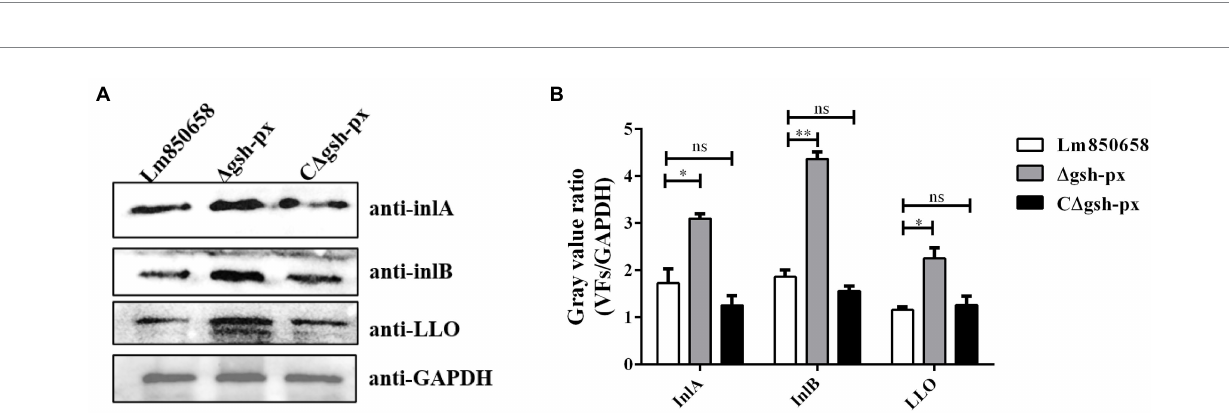
FIGURE 6 Deletion of gsh-px upregulated the expression of major virulence factors in L. monocytogenes. Overnight cultured bacteria were collected and the expression levels of the major virulence factor InlA, InlB and LLO were measured by western blot (A) . The gray value ratio was calculated by the band gray value of virulence factor relative to that of GAPDH (B) . Data were expressed as mean ± SD. ns, no significance; *, p < 0.05; **, p <